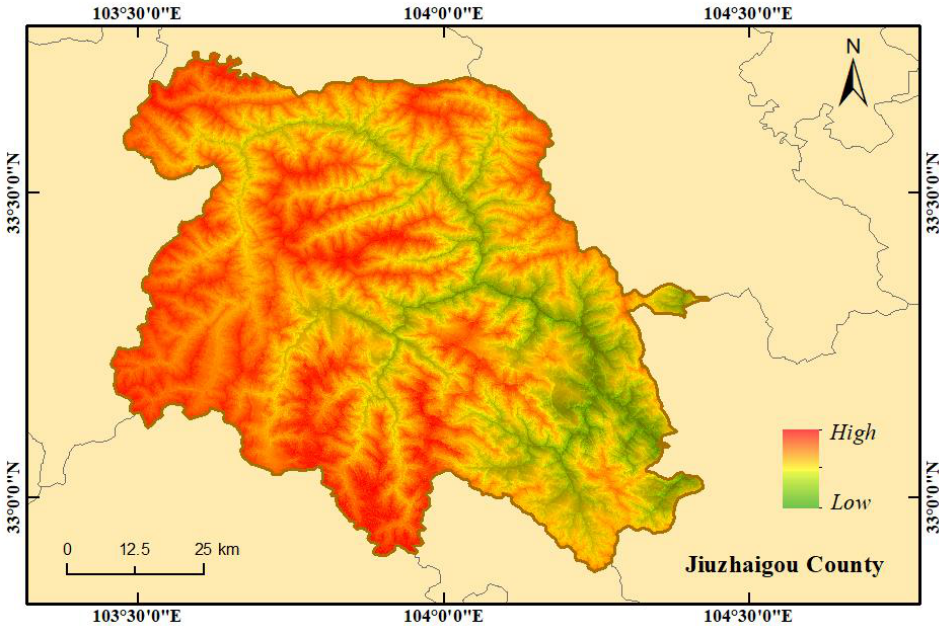
Figure 7. Topography of Jiuzhaigou county. We used a rendering method to display the DEM, so there is not a precise numerical representation, but rather high and low elevation.